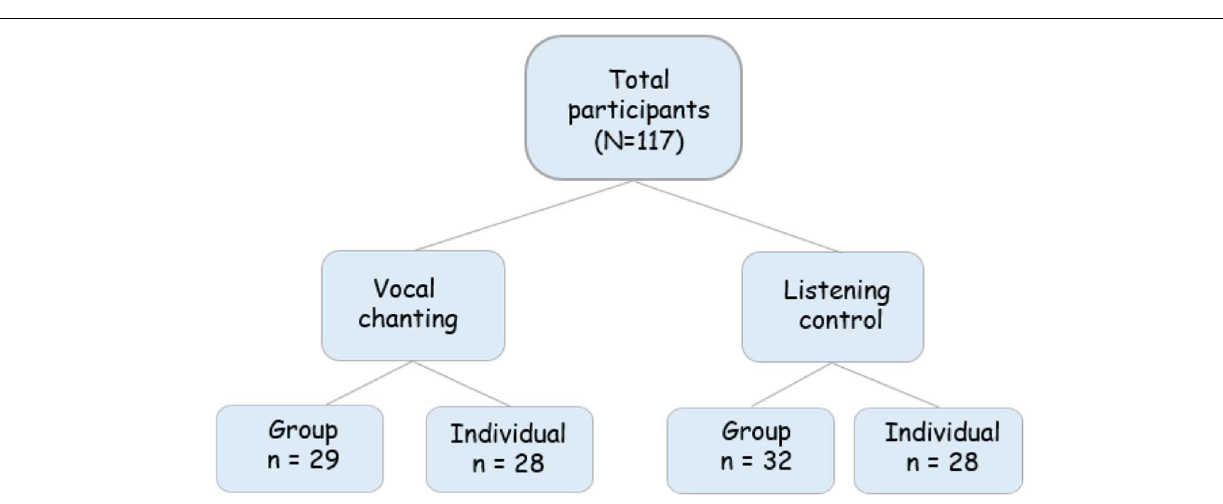
FIGURE 4 | Illustration of the conditions and participants.